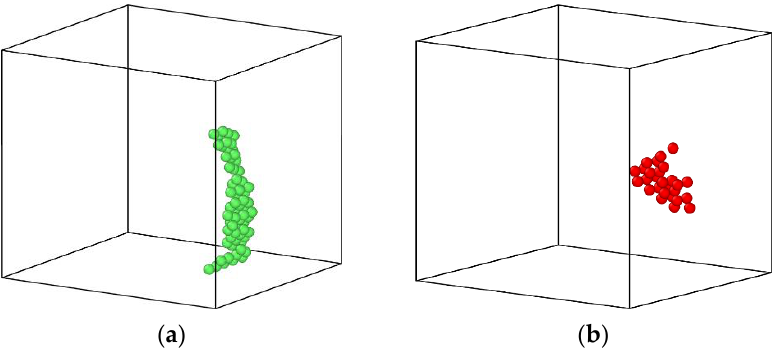
Figure 10. The initial area of structural phase change and the Cu precipitate with the maximum size in the Fe-3.5Cu-0.1V alloy during the tensile process ( a ) The area of structural phase change at a strain of 7.6% ( b ) Cu precipitate.